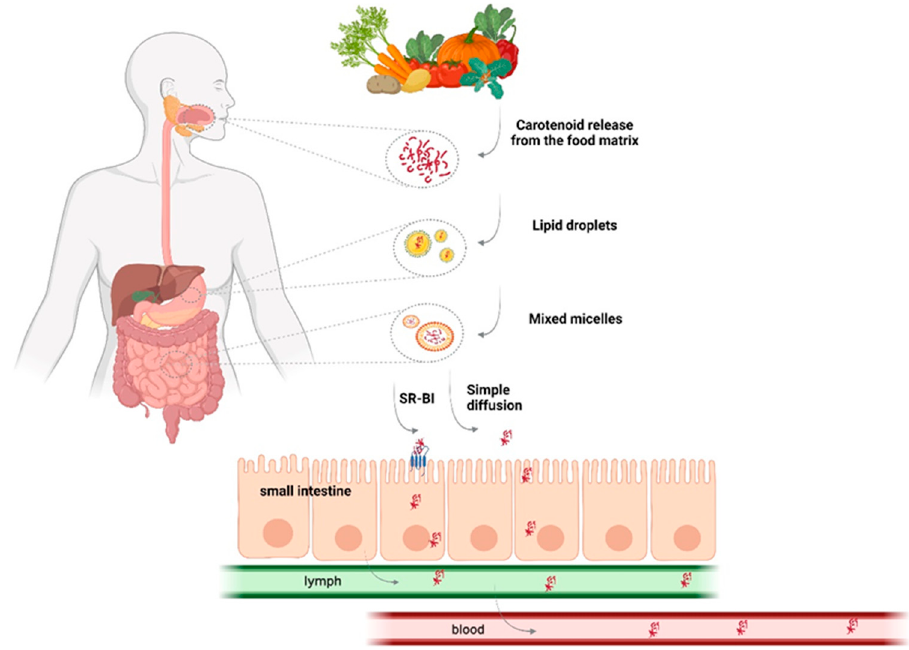
Figure 4. Schematic representation of the absorption of carotenoids (Created with “https://www.biorender.com (accessed on 12 December 2023)”.